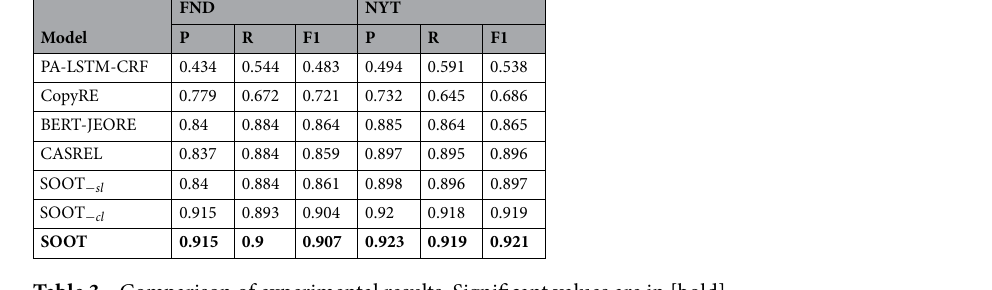
Table 3. Comparison of experimental results. Significant values are in